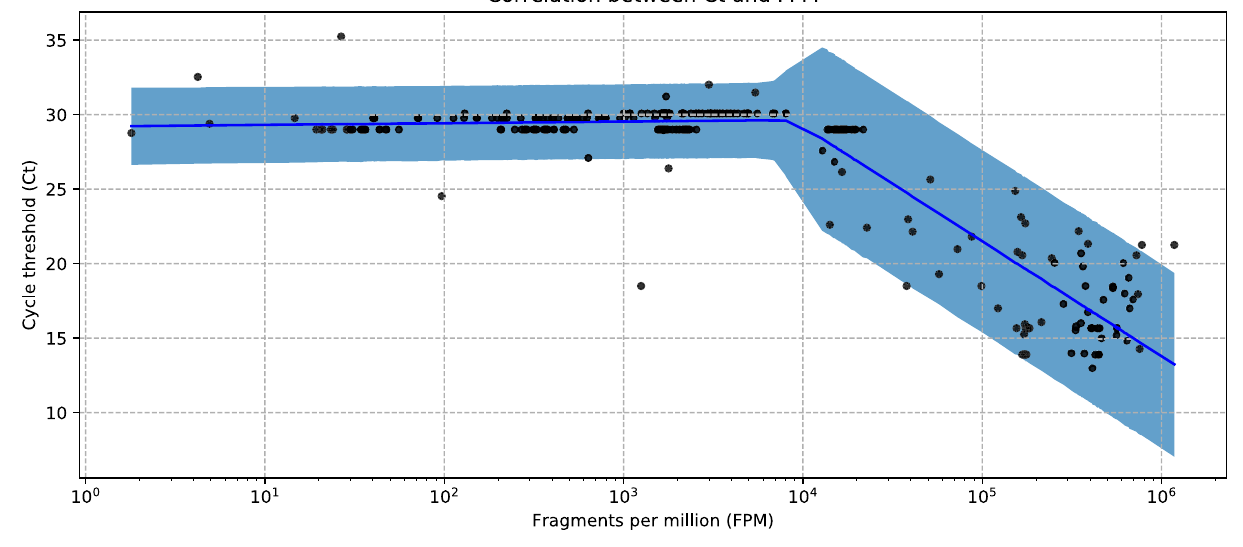
Figure 3. Correlation between RT-PCR cycle threshold and Fragments per Million. The blue line indicates the posterior median of the Ct for each value of FPM. Blue shade indicates 95% posterior predictive interval (that is, 95% of new samples are expected to fall within this